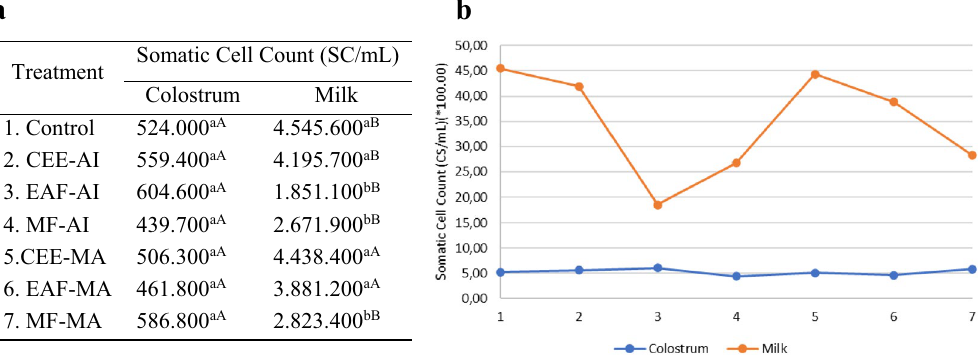
Figure 6. Tabulated values ( a ) and graphs ( b ) of somatic cell count (SCC) by the microscopic method in colostrum and goat milk samples after treatment with the crude extracts of Azadirachta. indica and Melia azedarach and the organic fractions of Ethyl Acetate and Methanol for 90 min of action. Different letters in the same column differ from each other by Tukey’s test P < 0.01 CEE-AI: crude ethanolic extract— Azadirachta indica ; EAF-AI: ethyl acetate fraction— Azadirachta indica ; MF-AI: fraction methanol Azadirachta indica ; CEE-MA: crude ethanolic extract— Melia azedarach ; EAF-MA: ethyl acetate fraction— Melia azedarach ; MF-MA: fraction methanol— Melia azedarach .